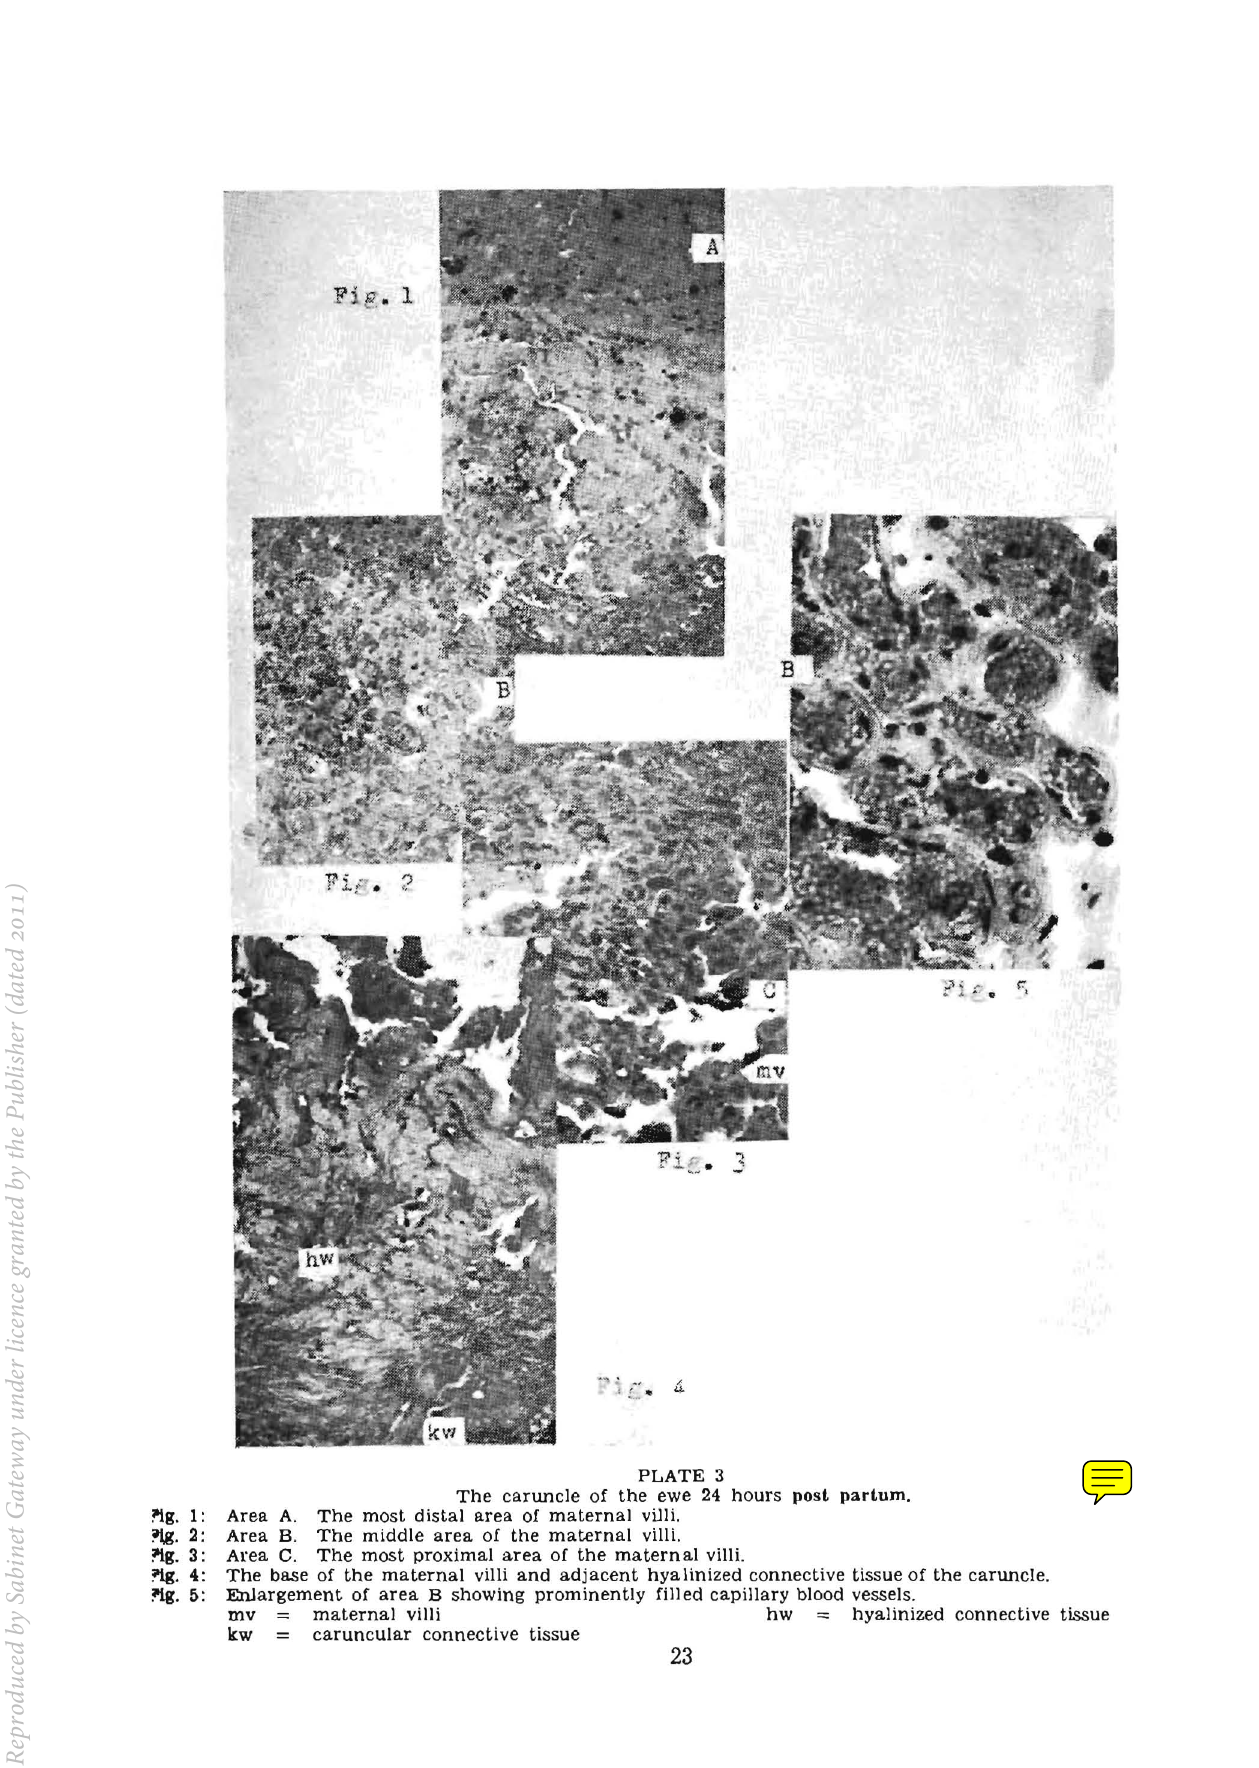
Area B. The middle area of the maternal villi. Area C. The most proximal area of the maternal villi. mv maternal villi hw hyalinized connective tissue kw